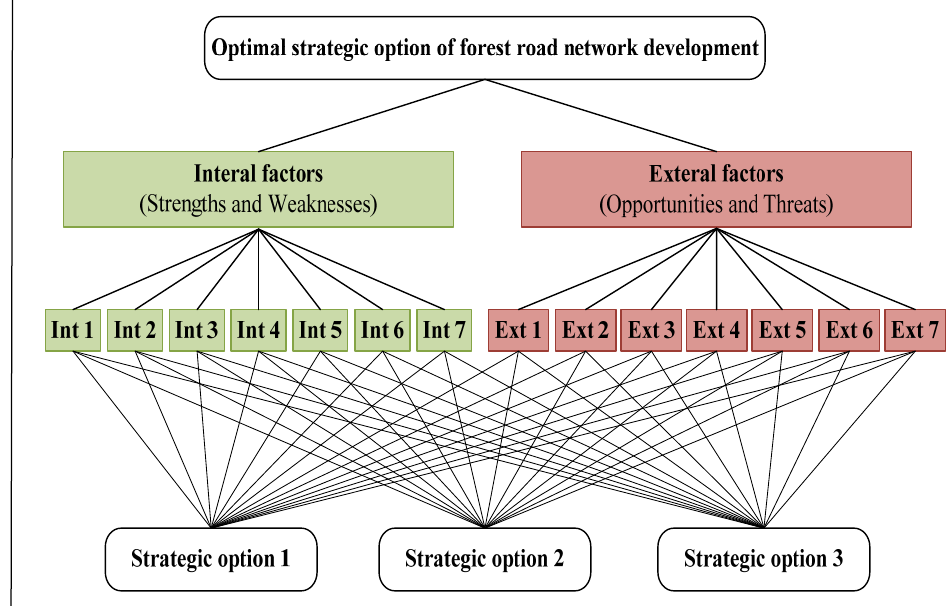
Figure 4 – A’WOT hierarchical model for the selection of the optimal development